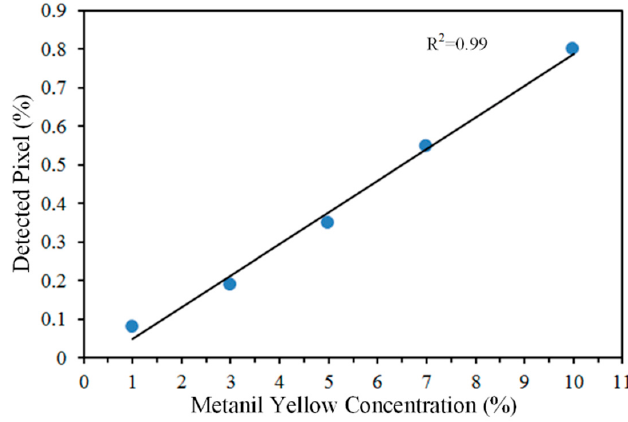
Figure 7. Relationship between actual metanil yellow concentration and percentage of its detected pixels in 1147 cm − 1 binary image.